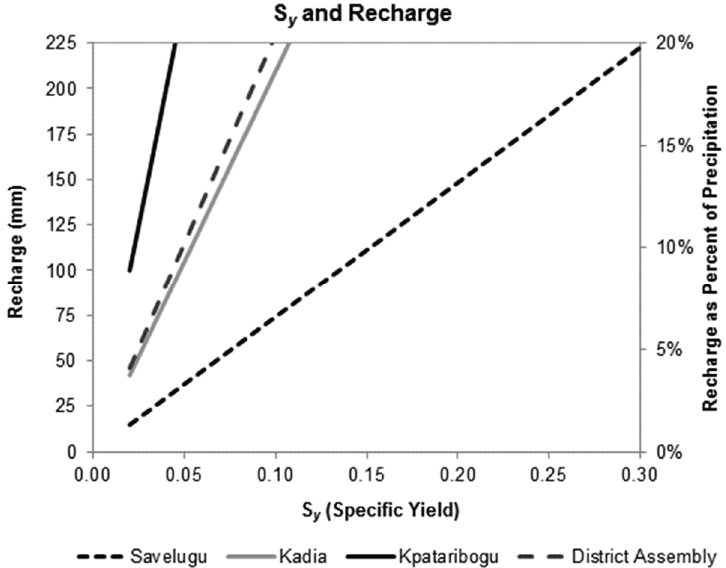
Figure 6. Range of recharge estimates for study sites using values of S y (specific